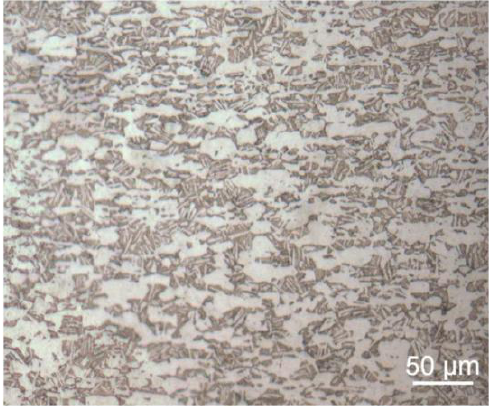
Figure 4. Bimodal microstructure of Ti-6Al-4V after the STOA treatment. Magnification: 200×.